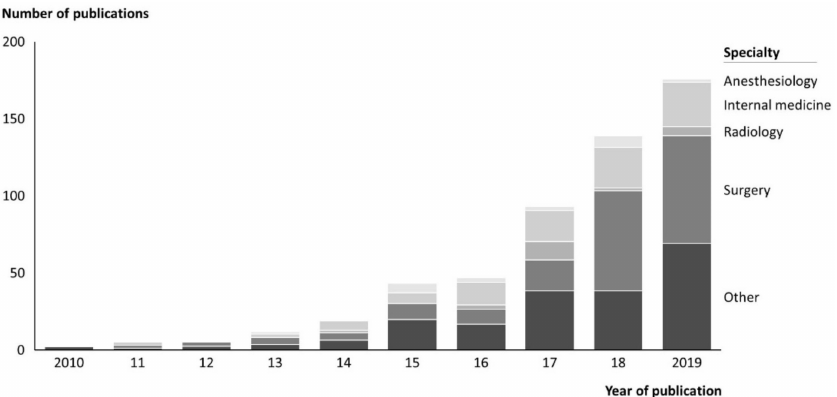
Figure 2. Publications on VBC. The increasing number of VBC related publications are shown over the past 10 years, split by subject.